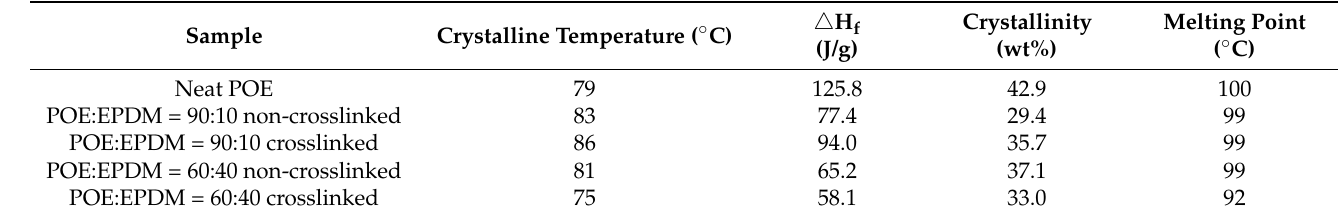
Table 2. Crystallization temperature, enthalpy of fusion, crystallinity, and melting point of neat POE and POE/EPDM blends with and without dynamic